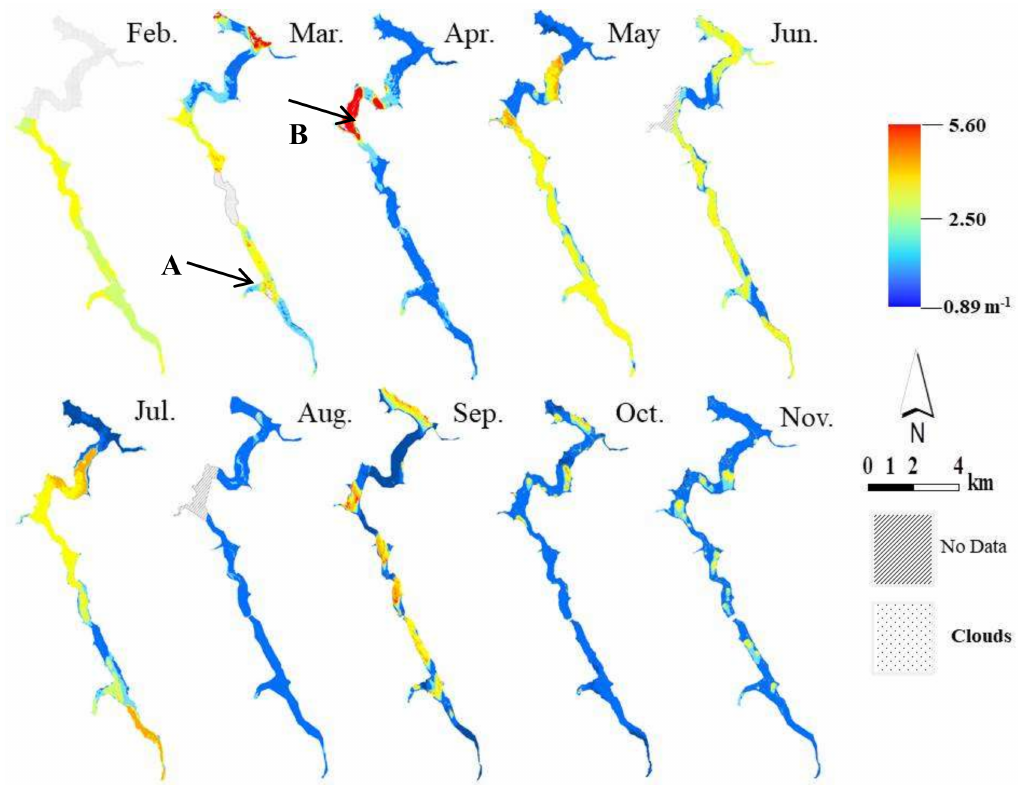
Figure 7. Spatial distribution of k d (490) in Bariri reservoir using the semi-analytical model from Lee et al. [9] considering the months from February to November of 2016. The arrows A and B highlight the reservoirs zones near urban